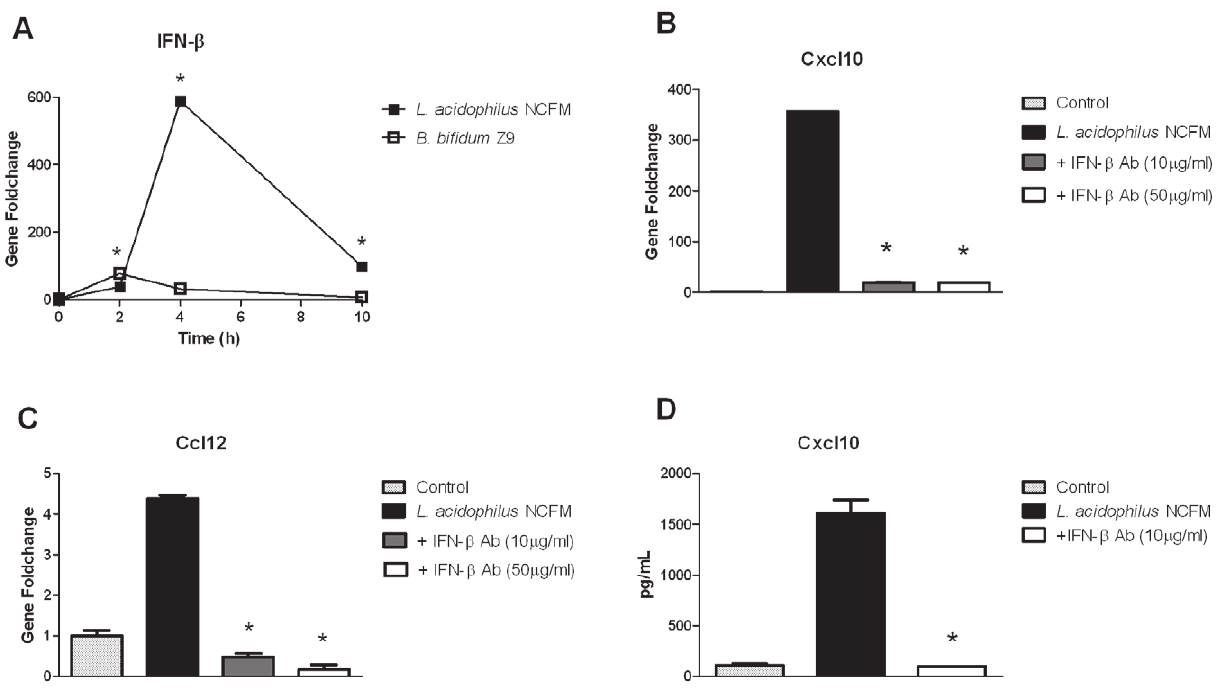
Figure 5. Lactobacillusacidophilus NCFM induces IFN- b in dendritic cells. The IFN- b encoding gene is strongly up-regulated in L .acidophilus NCFM stimulated dendritic cells and responsible for the expression of the chemokines Cxcl10 and Ccl12. A . Expression of the IFN- b encoding gene over time in dendritic cells upon stimulation with L. acidophilus NCFM and B. bifidum Z9. B . Inhibition of IFN- b activity induced by L. acidophilus NCFM by addition of polyclonal IFN- b antibodies measured via the gene expression of the chemokine Cxcl10 after 10 h and C . via the gene expression of the chemokine Ccl12 after 10 h and D . via protein production of Cxcl10 in the supernatant after 24 h of stimulation by ELISA ( P , 0.01). doi:10.1371/journal.pone.0011065.g005 resulted in a subdivision of genes encoding for cytokines (interleukins and chemokines) according to the differential stimu- lation regime, which was not revealed by the gene set enrichment.